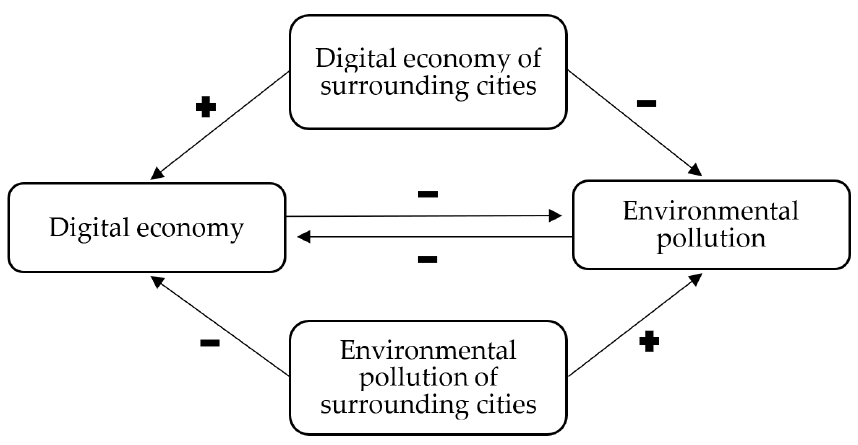
Figure 2. The link between the digital economy and pollution in the environment.